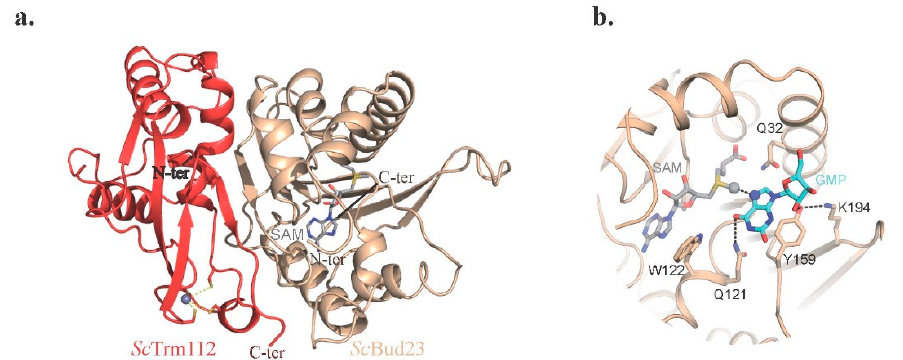
Figure 5. Crystal structure of the S. cerevisiae ( Sc ) Bud23-Trm112 complex. ( a ) Ribbon representation of the Sc Bud23-Trm112 complex bound to SAM. ( b ) Model of guanosine monophosphate (GMP) (blue sticks) bound to the Sc Bud23 active site.